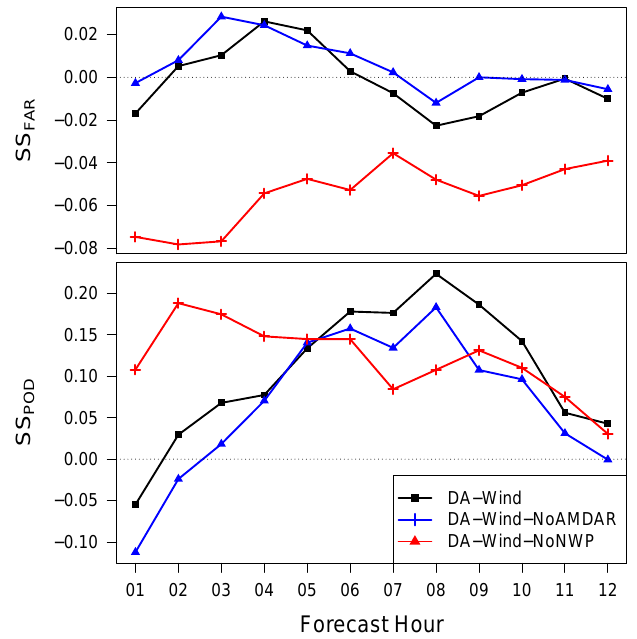
Figure 7. Evolution of skill scores of POD and FAR as a function of forecast